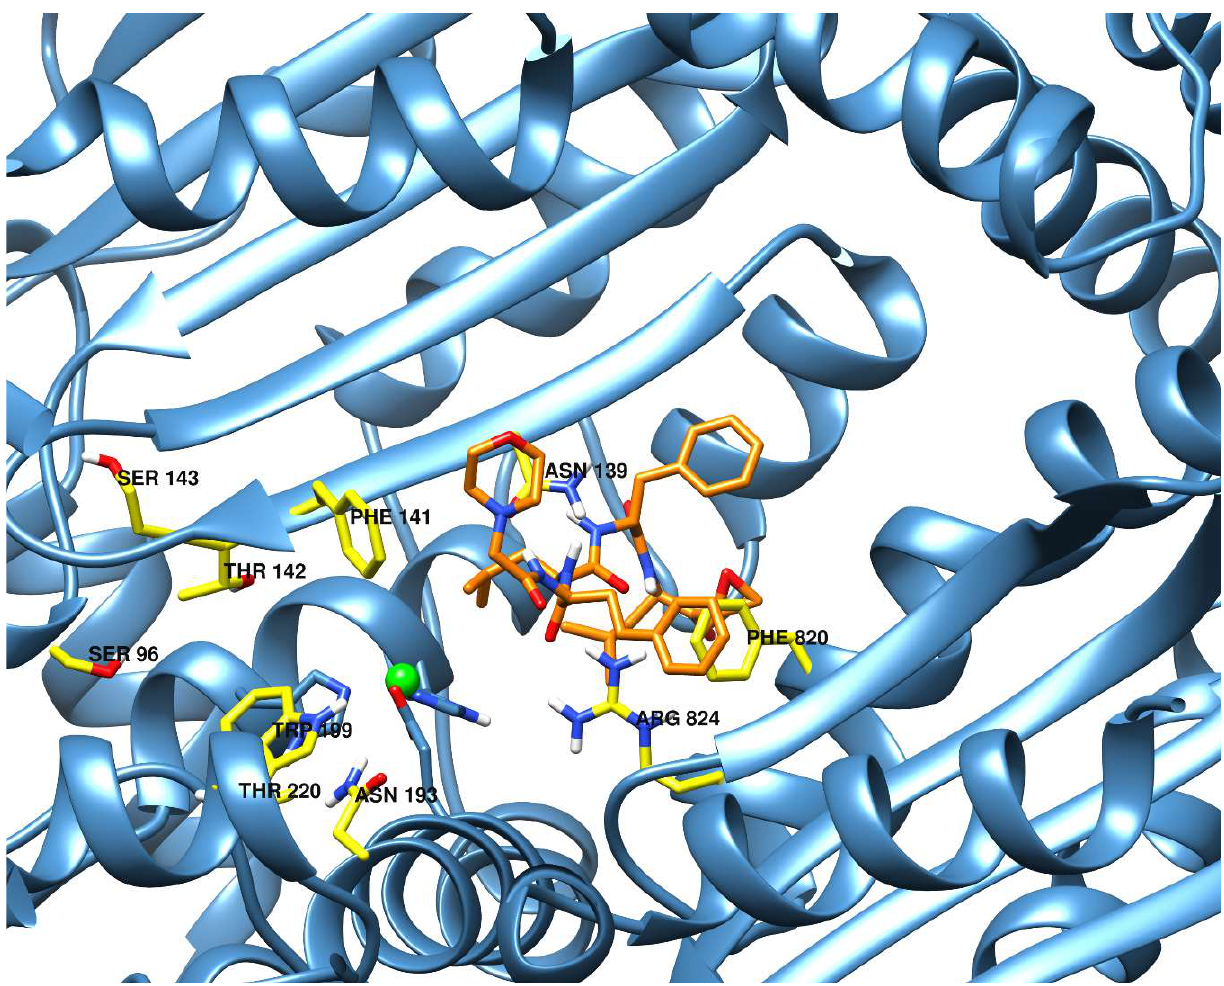
Figure 2. Schematic representation of the three-dimensional structure of the predicted best binding affinity complex formed by IDE with CFZ. For clarity, CFZ carbon atoms are colored in orange and the zinc ion in green.